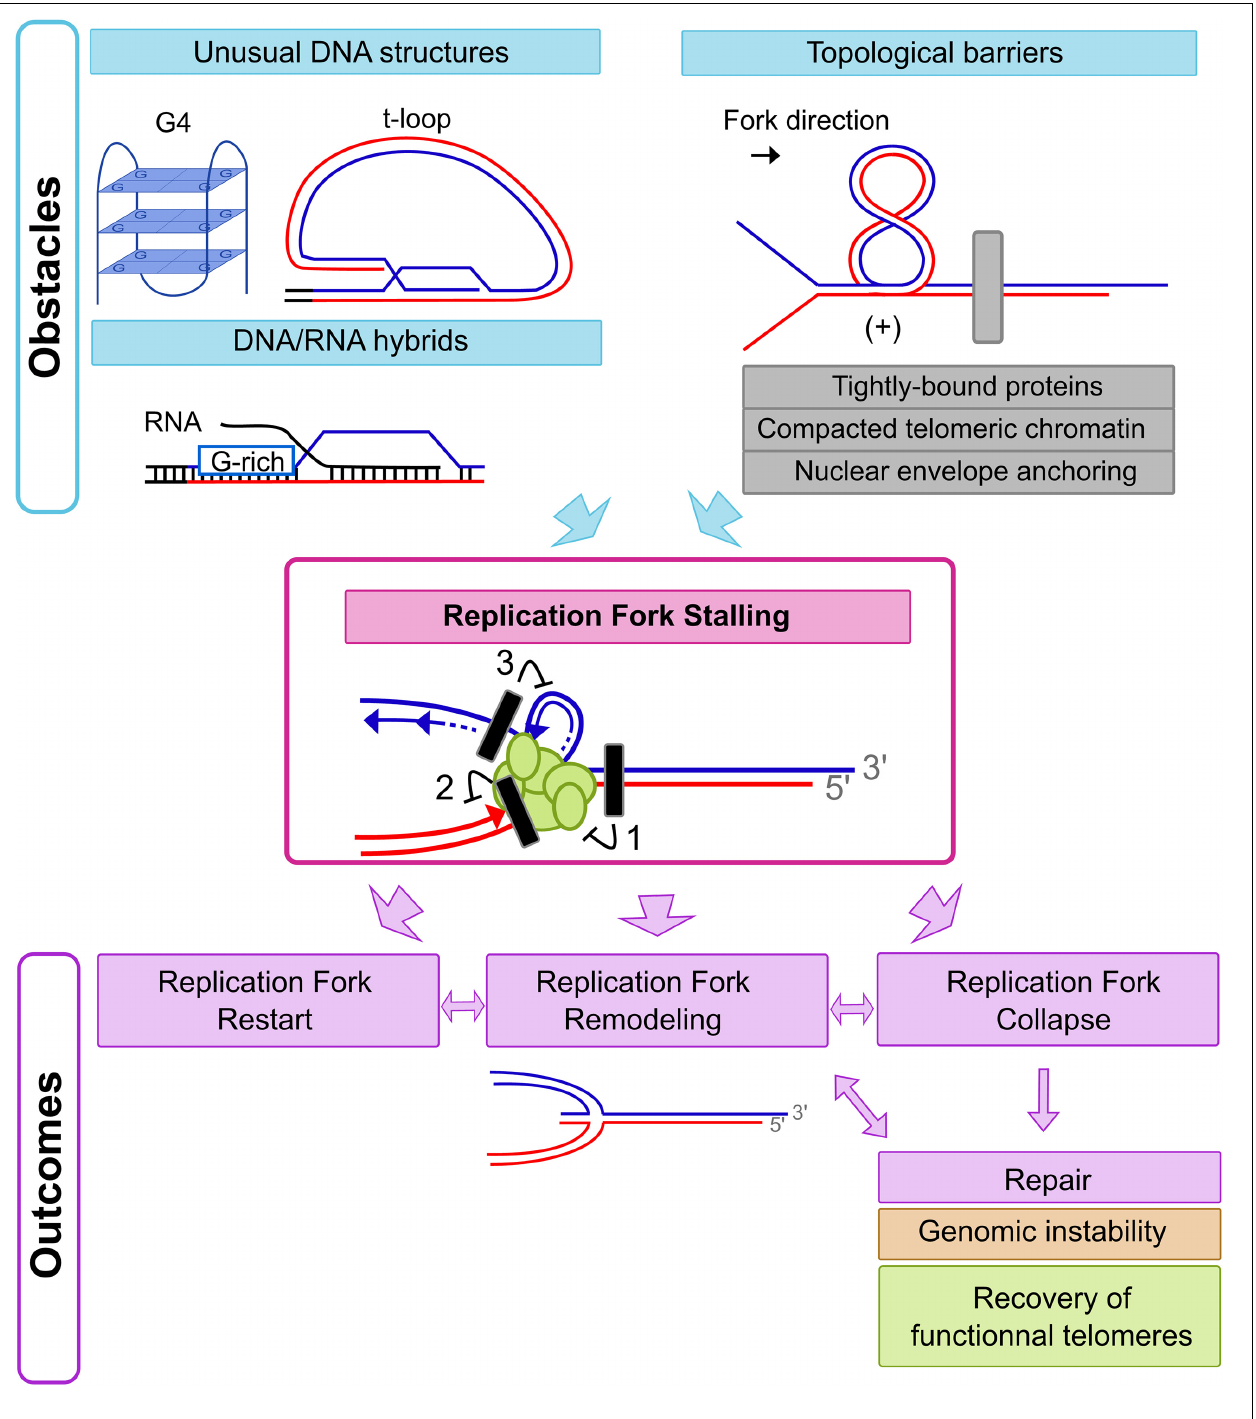
FIGURE 2 | Initiation and outcomes of Replication Fork Stalling at chromosomal ends. Replication forks could stall just upstream to or on telomeric repeat tracts due to different obstacles. Hampering of replication fork progression may be caused by an incapacity of DNA unwinding by replicative helicases (block 1), a situation expected in the context of topological barriers (gray rectangle on the figure). Tightly bound proteins, compacted telomeric chromatin, and nuclear envelope anchoring are strong topological barriers at chromosomal ends. In humans, the unusual DNA structure of the t-loop could also induce a topological stress in front of the replication fork. At least two other situations could induce replication fork stalling with lesions inhibiting only leading strand synthesis (block 2) or lagging strand synthesis (block 3). Given that G4s could be formed on the G-rich strand (blue line) during lagging strand synthesis, a lagging strand specific defect could be expected with this kind of replication stress. In contrast, t-loops or DNA/RNA hybrids could lead to leading strand synthesis defects. Depending on the kind of replication stress encountered, there are various pathways to deal with the consequences of a stalled replication fork. Replication restart can occur by alleviation of the replication stress and repriming events. Replication fork remodeling with fork reversal could also follow replication fork stalling. In addition, complete collapse of the replication fork could occur, resulting in DSBs or one-sided DSBs that initiate appropriate or inappropriate repair pathways.